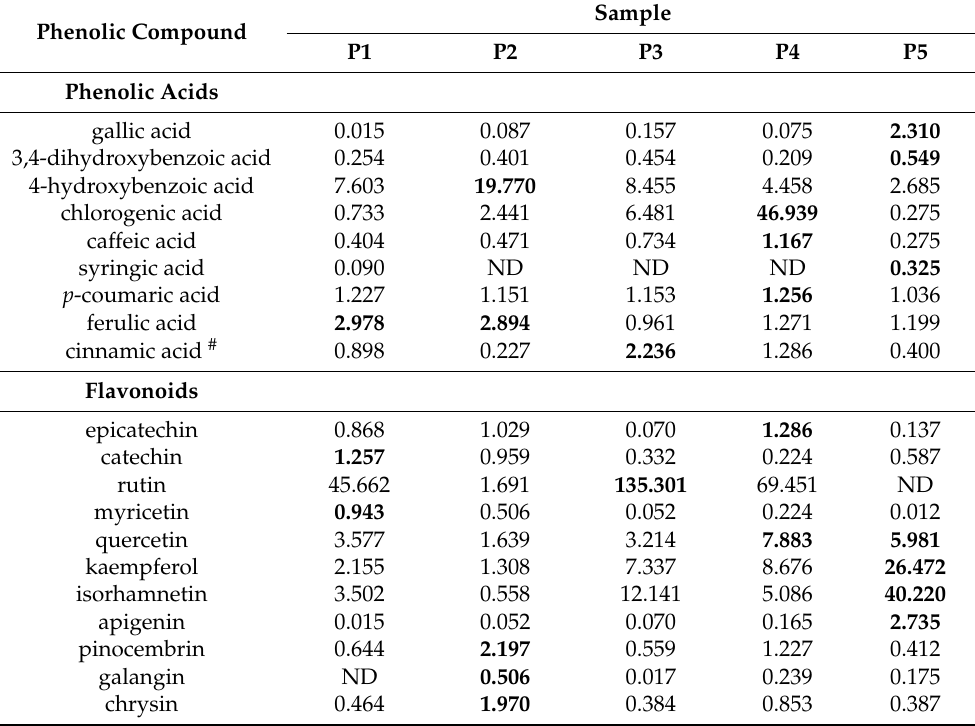
Table 4. The phenolic acid and flavonoid concentrations from BP ( µ